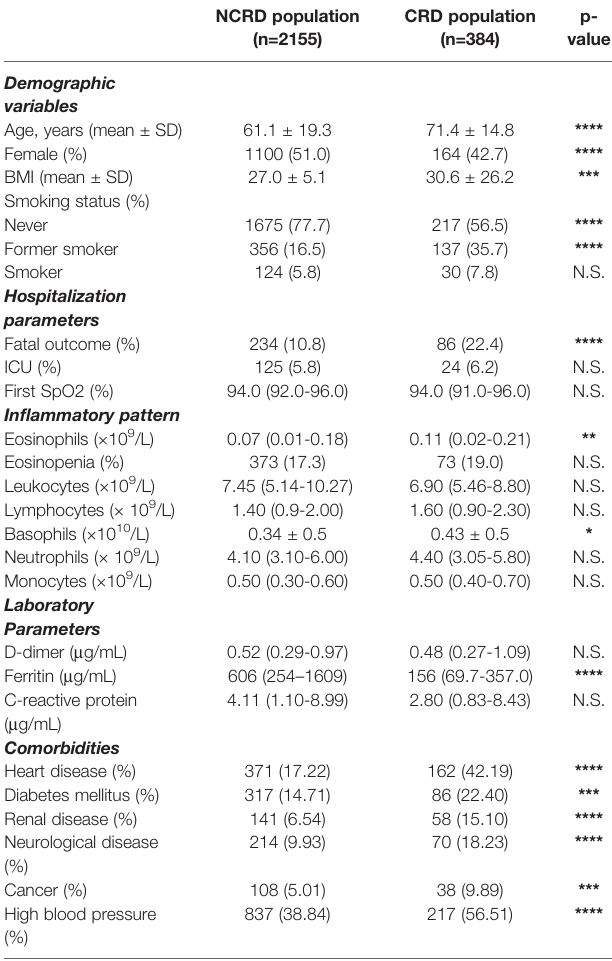
TABLE 1 | Demographic and clinical data of patients from the CRD and NCRD